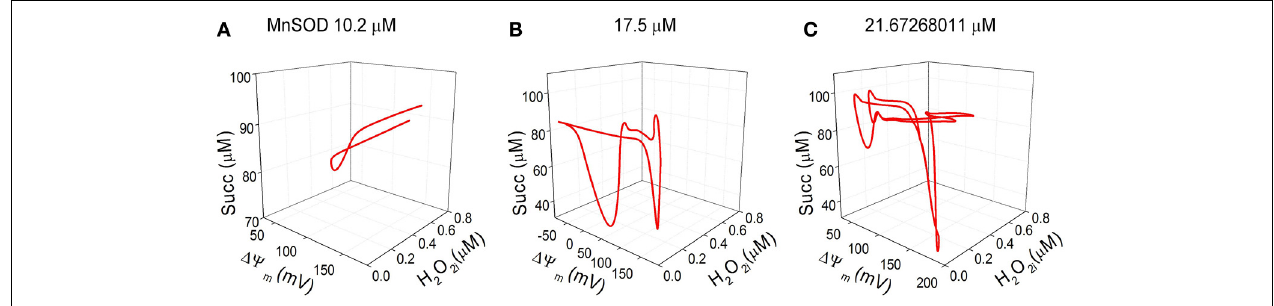
FIGURE 6 | Three-dimensional (3D) phase space projections of energetic and redox state variables. 3D phase space plots depicting the interrelationship between the dynamic trajectories of the state variables